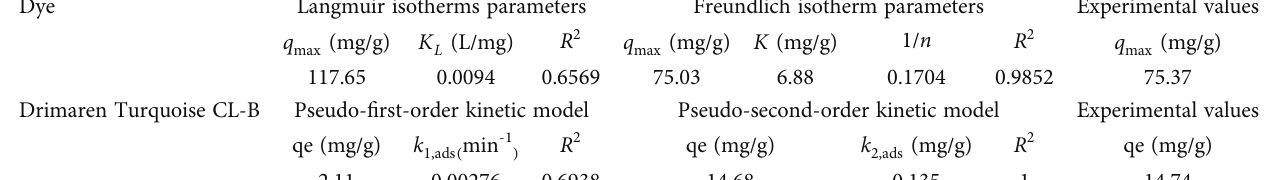
Figure 4: E ff ect of (a) pH, (b) temperature, and (c) dye concentration on the removal of Drimaren Turquoise CL-B by Schizophyllum commune biomass. Table 6: Comparison of Langmuir, Freundlich isotherms, pseudo-1 st -order, and pseudo-2 nd -order kinetics model parameters for removal of Drimaren turquoise CL-B. Dye